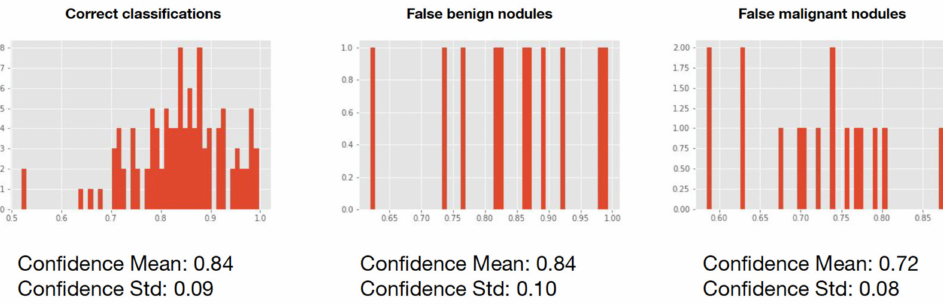
Figure 8. Confidence mean and standard deviation for correct classifications, false benign nodules and false malignant